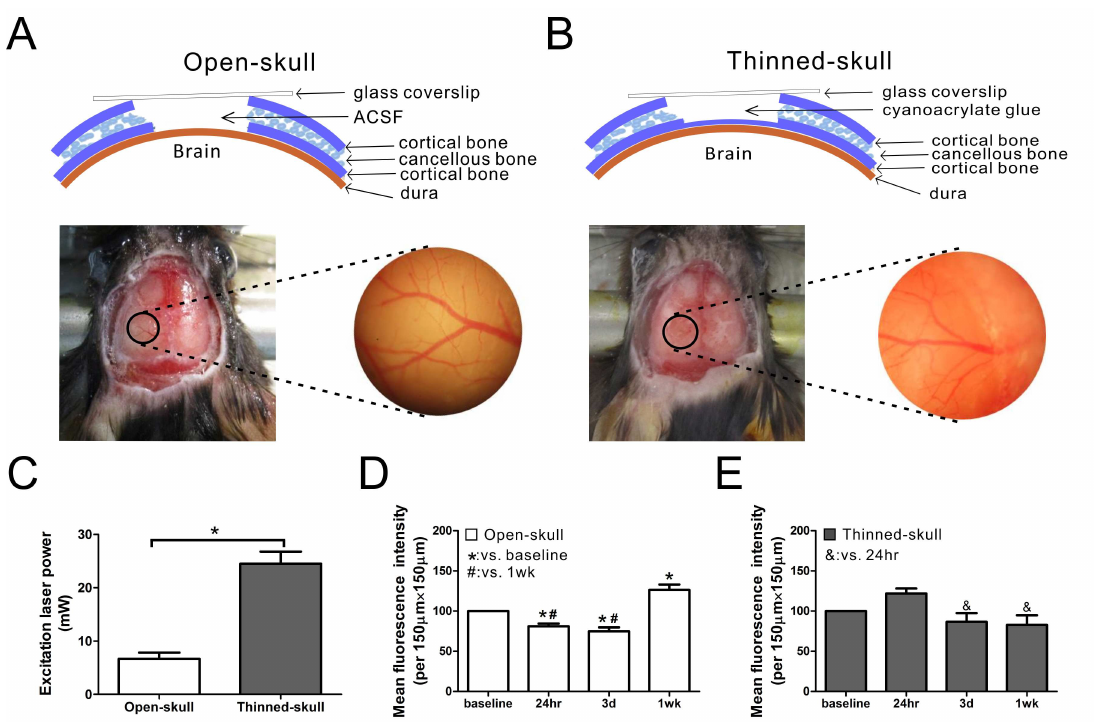
Fig 1. Schematic diagram and image analysis of open-skull technique and thinned-skull techniques for in vivo imaging of astrocytes in GFAP-GFP mice. (A,B) The mouse skull consists of two thin layers of cortical bone and a thick layer of cancellous bone. In the open-skull technique,all three layers of skull are removed and the exposeddura is coated with ACSF and coveredwith a glass coverslipover the skull window(A). In the thinned-skull technique, the skull is carefullythinnedto the inner cortical boneto about 20 μ m in thickness. The thinnedskull is coated with a layer of cyanoacrylateglue and coveredwith a glass coverslipover the skull window(B). In both techniques, a round area of skull (~2 mm in diameter, marked with black circle) over the left somatosensory neocortex is removed(A) or thinned(B). Vasculature images captured after surgery help to ensure repeated observationfrom the same areas. (C) About 7 mW excitationlaser power was neededfor goodimage quality in the open-skull techniquebut much higher laser power (~25 mW) was requiredin thinned-skull techniqueto providea similar image intensity ( * p < 0.05by t-test, n = 6 per group). (D) In the open-skull technique, mean fluorescence intensity decreased24 hr and 3 d after surgery but increasedat 1wk ( * ,# p < 0.05by one-wayANOVA with Tukey post test, n = 6 per group). (E) In contrast, no significantchangeof mean fluorescence intensity was observed in the thinned-skulltechniqueover time compared with baseline(p > 0.05), althoughthere was a slight decrease in intensity at 3 d and 1 wk comparedto 24 hr (& p < 0.05by one- way ANOVA with Tukey post-test, n = 6 per